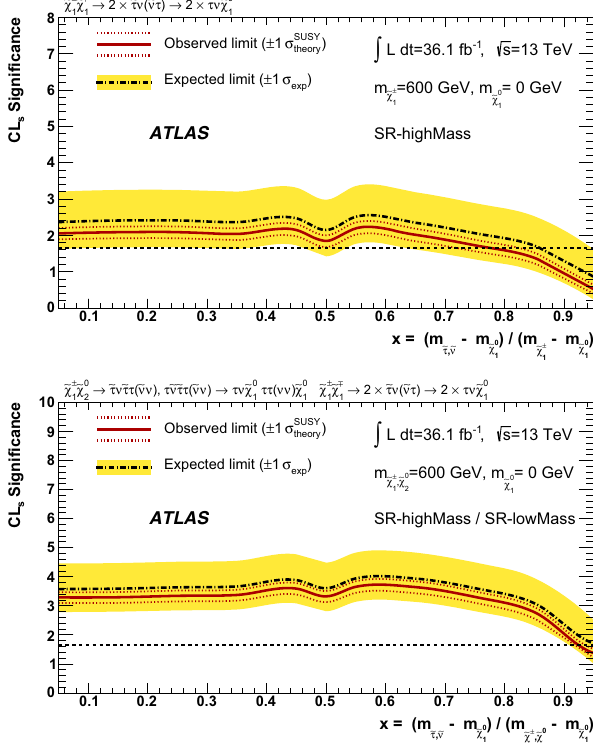
˜ χ − ˜ χ + 1 1 production (top), and SR-highMass is used for ˜ χ ˜ χ 0 expected CL s value for each point of the parameter space is used for 1 ) = ˜ χ